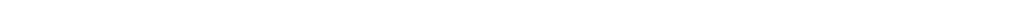
Figure 2: Availability of the four transplant centres with multiple organ transplant programmes in Switzerland according to the stepwise shut- down approach described in “Patients and methods” (table 2) over time. Shown here are weekly statuses from 9 March 11 to May